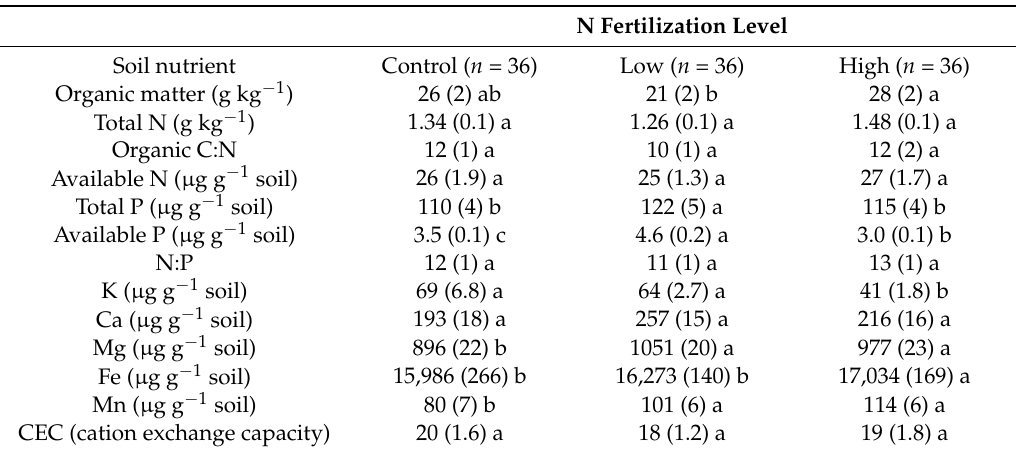
Table 1. Mean levels of soil nutrients in control and N-fertilized plots. Data represents mean with the standard error in